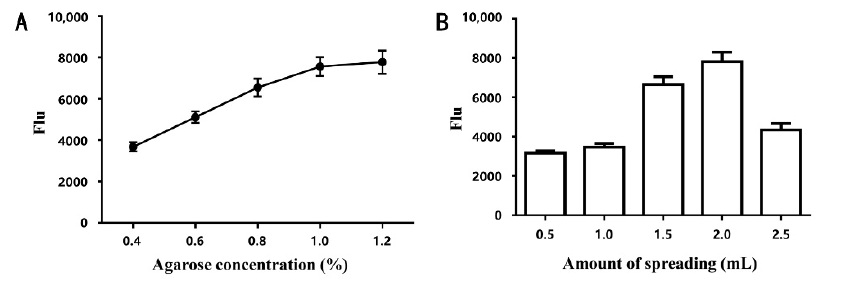
Figure 1. Optimization of agarose concentration ( A ) and amount of spreading ( B ) for agarose-modified slides.